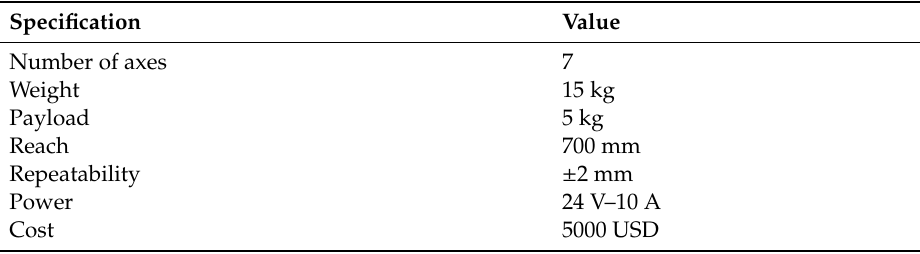
Table 4. The specification of self-developed robot